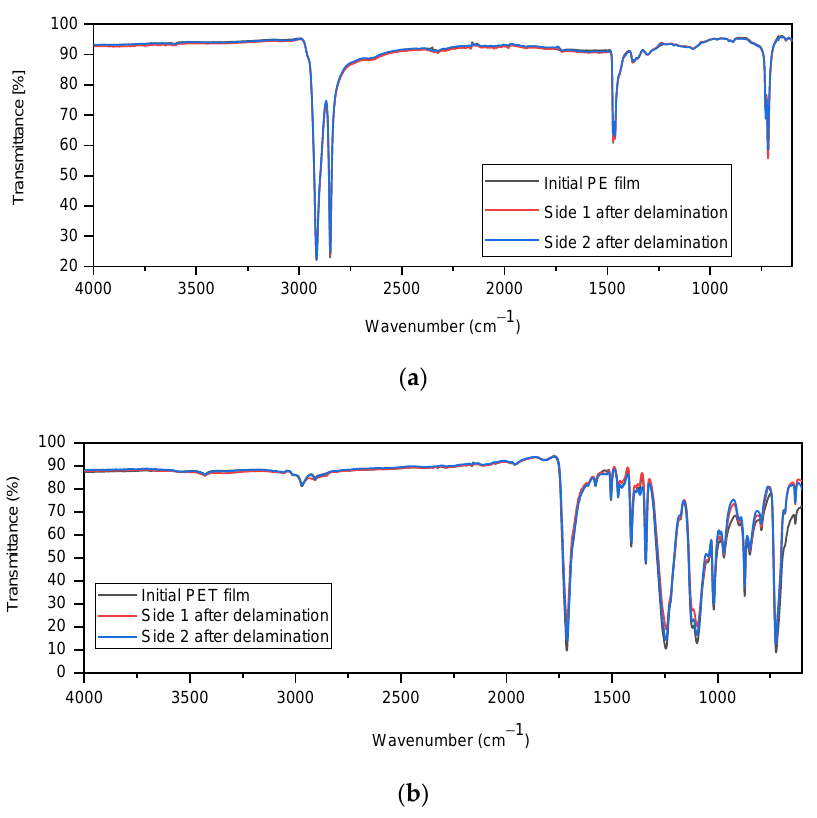
Figure 12. IR spectra of both sides of a delaminated film (( a ) PE, ( b ) PET) and the respective starting film as reference. Table 4. Overview of the quantities of the floating and sinking fractions obtained after density separation and the solvent fraction containing the